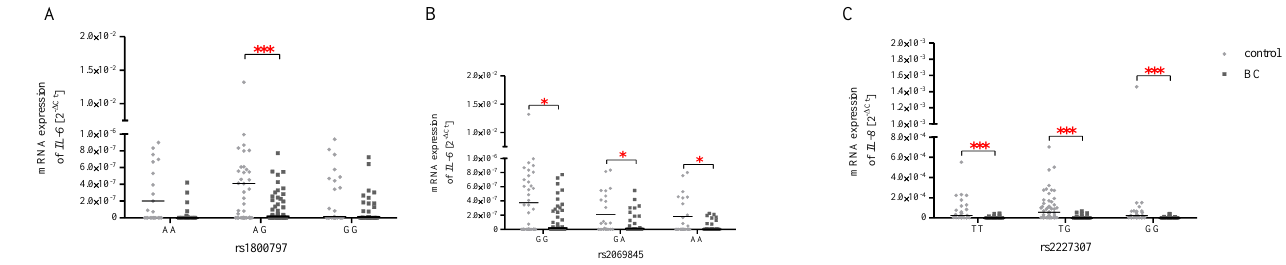
Figure 4. Relative IL-6 ( A , B ) and IL-8 ( C ) expression in PBMCs in the genotype groups of all studied SNPs, expressed using the 2 − ∆ Ct (C t gene − C t 18S ) method for each sample. The data are plotted as individual values and the median with interquartile range is indicated by the horizontal bars; *— p < 0.05; ***— p < 0.001.